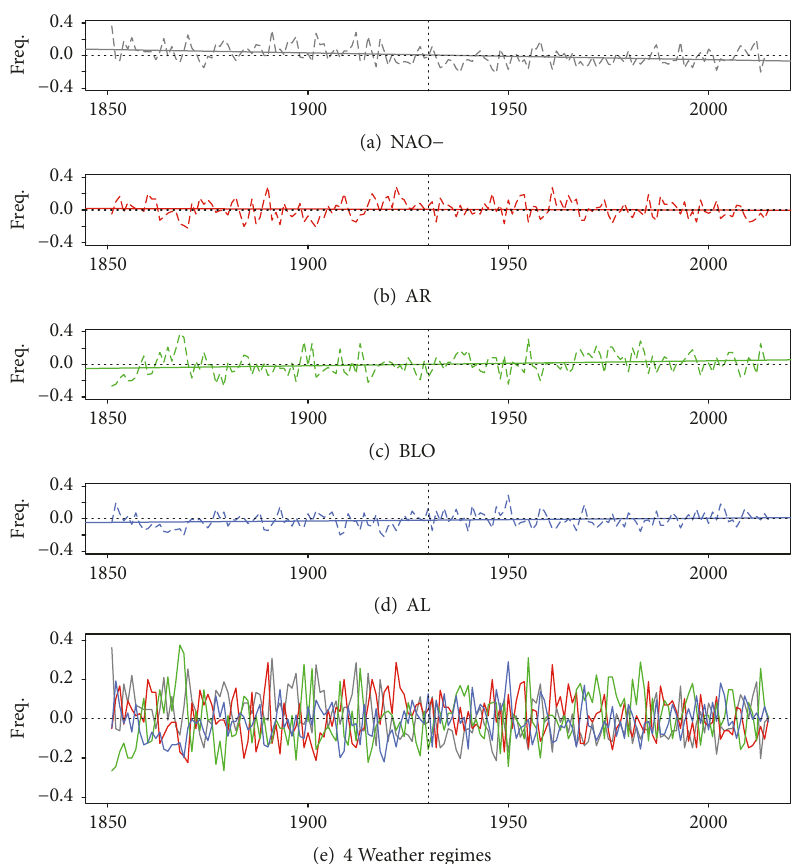
Figure 2: Relative long-term summer weather regime frequency. Relative frequency of summer SLP (hPa) weather regimes over the North- Atlantic region (1851–2014) using 20CRv2c. Here we show SLP anomalies with respect to the reference period 1970–2010 for each (a)–(d) and all (e) weather regimes; solid lines in (a)–(d) represent the linear trend for each regime. 1930 is marked with a vertical dashed